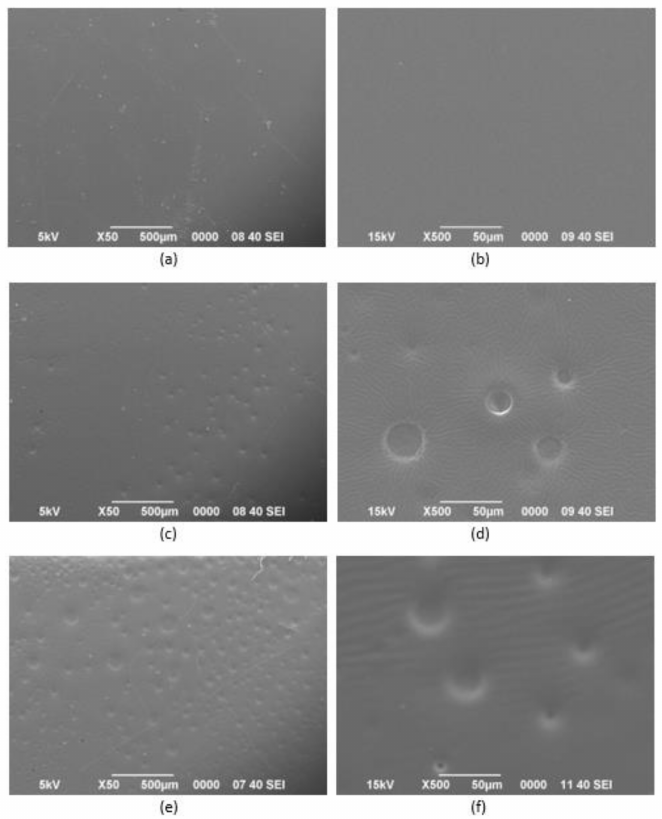
Figure 5. SEM images of the pristine polyurethane acrylate and fluorinated polyurethane acrylate: ( a ) PUA at 50 magnification; ( b ) PUA at 500 magnification; ( c ) FPUA-4 at 50 magnification; ( d ) FPUA-4 at 500 magnification; ( e ) FPUA-10 at 50 magnification and ( f ) FPUA-10 at 500